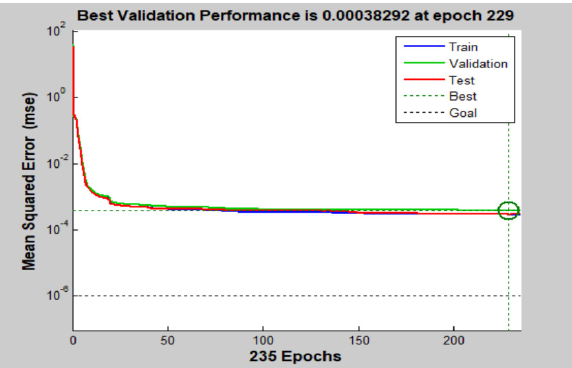
Figure 7. Training iterations of back propagation (BP) neural network.